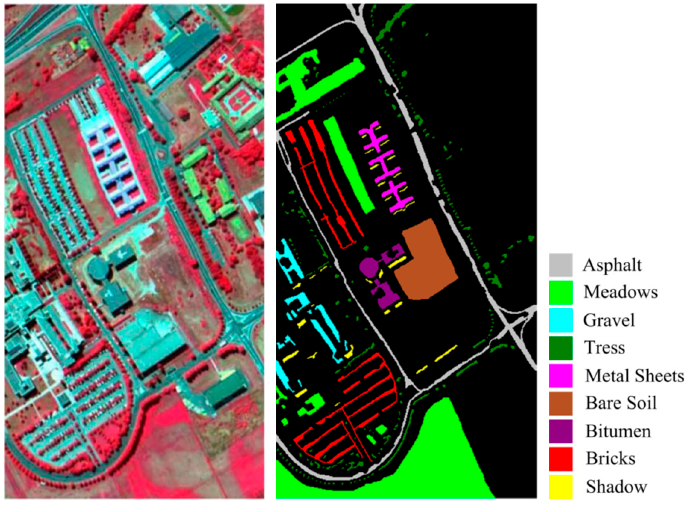
Figure A3. Ground-truth of Salinas scene with 16 classes